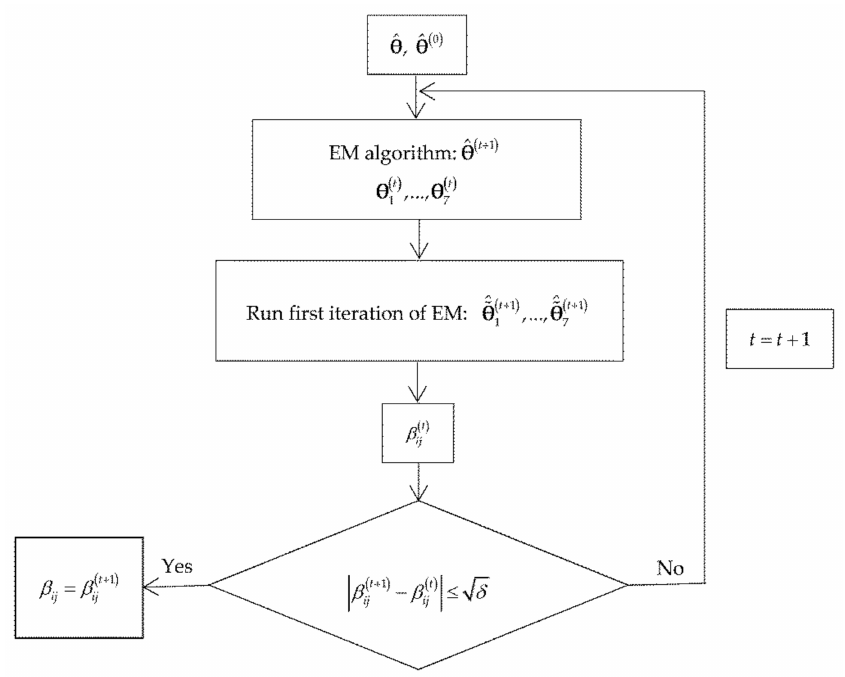
Figure 2. Flowchart of the second step of the SEM